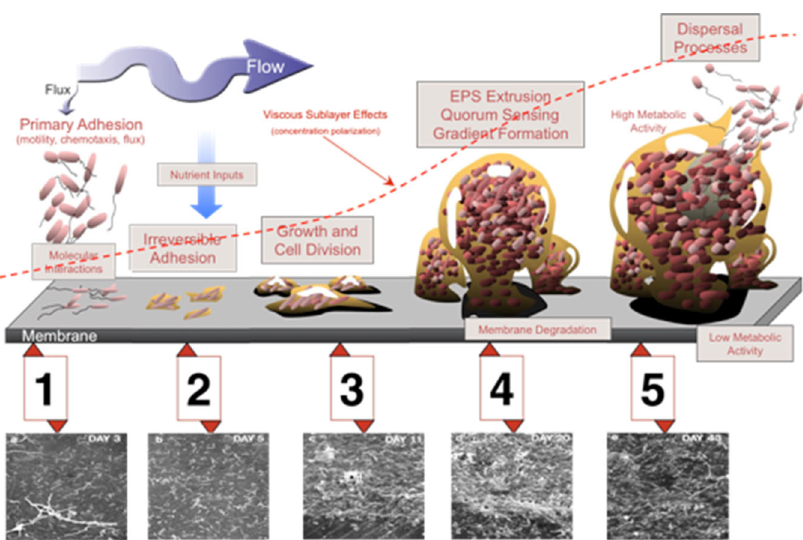
Fig. 6 The fi ve stages of biofouling. Illustration and SEM images of the fi ve major stages of bio fi lm formation and growth over time ( fi gure provided by Harry Ridgway 114